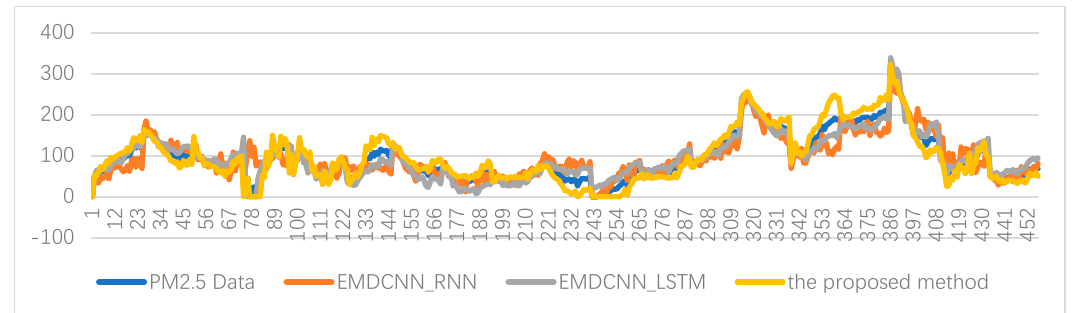
Figure 8. The predictions of hourly PM2.5 in Beijing from 1 to 20 December, 2017 by EMDCNN_RNN, EMDCNN_LSTM, and the proposed method. Table 1. Comparison of prediction results with different predictors.